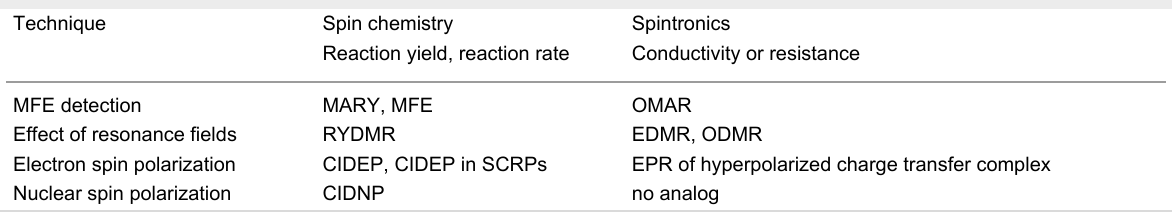
Table 3: Comparison of terminology and techniques for spin chemistry and